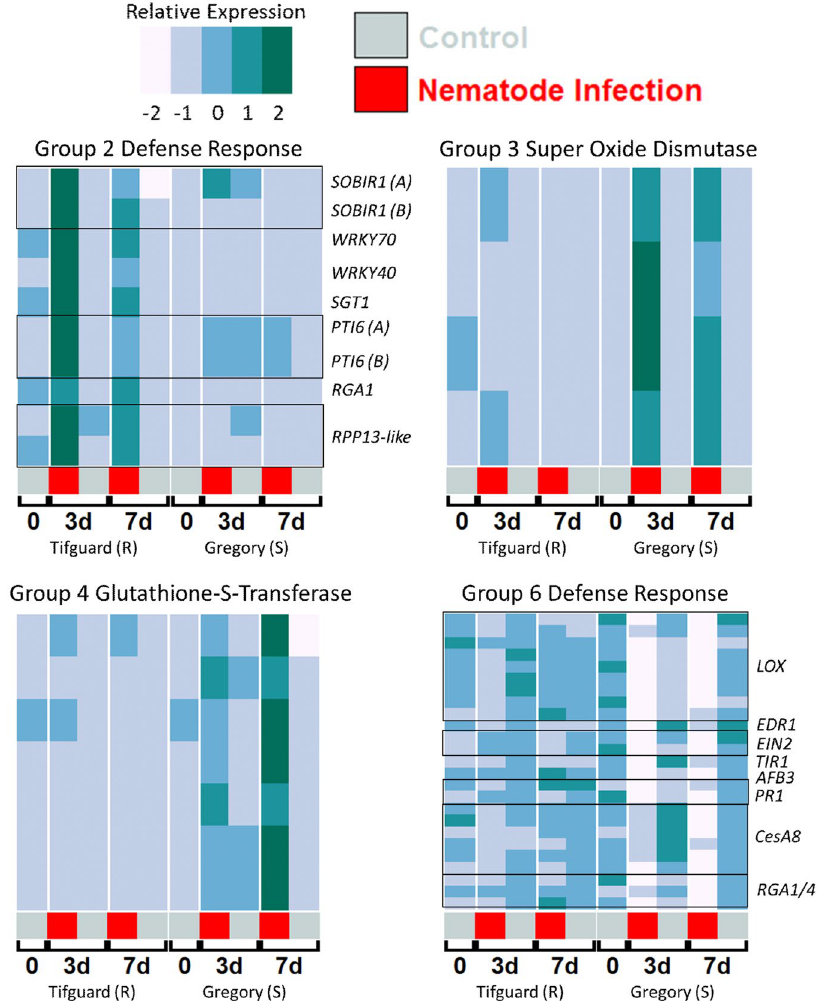
Figure 4. Expression heatmaps of individual differentially expressed genes from top GO enriched categories of selected groups. Individual genes representing top enriched GO terms from genotype x treatment-affected, differentially expressed gene clusters Group 2 (Resistant Responsive; “Defense response”), Group 3 (Susceptible Responsive; “Super Oxide Dismutase Activity”), Group 4 (Susceptible Responsive; “Glutathione Transferase Activity”), and Group 6 (Susceptible Suppressed; “Defense Response”). Heatmap expression is Z-score normalized relative expression. Uninoculated control (silver) samples and samples inoculated with 20,000 juvenile Meloidogyne arenaria (red) and harvested at 3 days (3d) or 7 days (7d) after inoculation. Black boxes in the heatmap indicate the genes are from the same family. For PTI and SOBIR1 the two genes are putative A and B homeologous